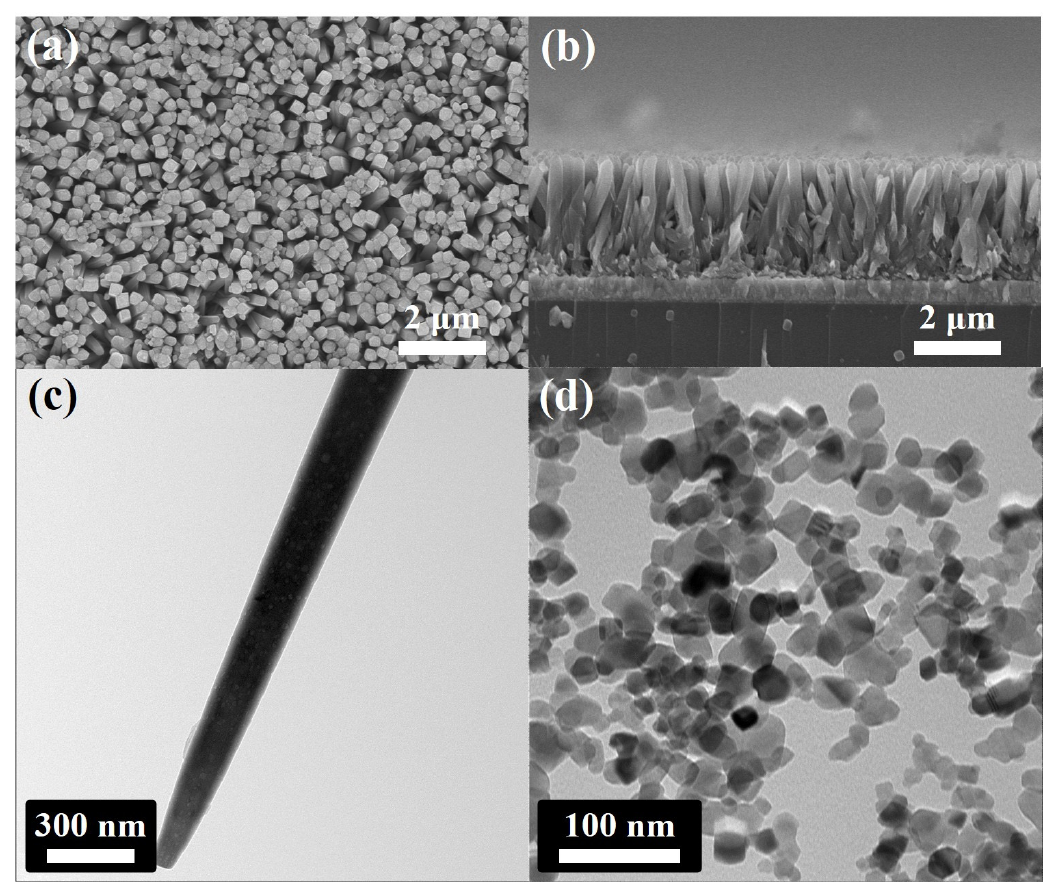
Figure 1. Field emission scanning electron microscopy (FE-SEM) images of vertically aligned 1D TiO 2 grown on Fluorine- doped tin oxide (FTO) glass via the hydrothermal process: ( a ) top-view and ( b ) cross-section of 1D TiO 2 . Transmission electron microscope (TEM) image of ( c ) 1D TiO 2 and ( d ) commercial TiO 2 .